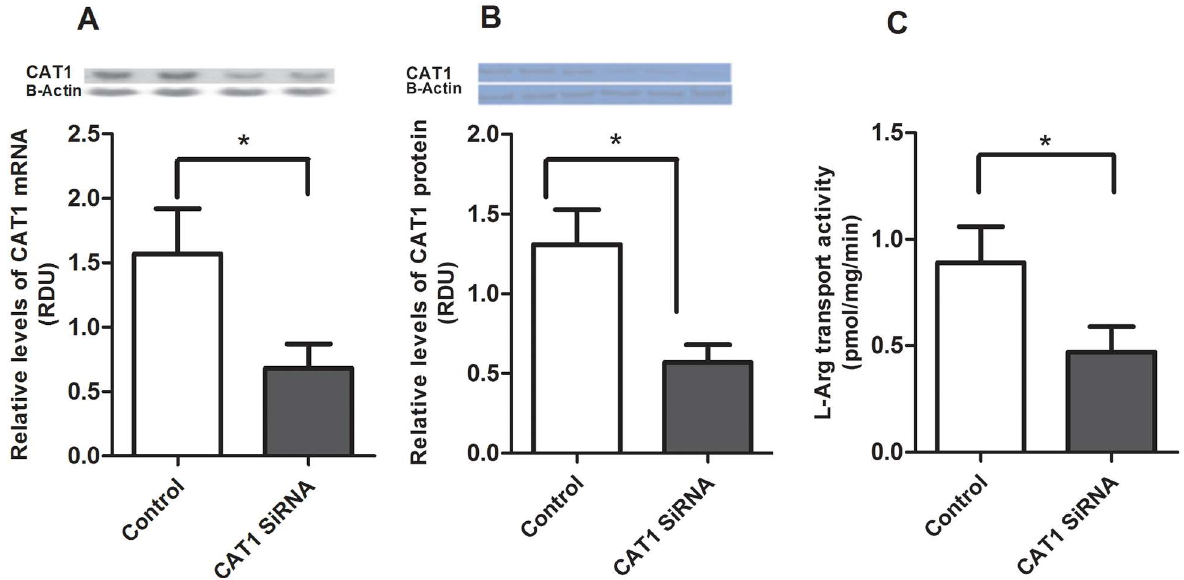
Fig 3. System y + CAT1 siRNA knocked down L-Arg transport activity, CAT1 mRNA and System y + protein. Caco-2 cells were transfectedsystem y + CAT1 siRNA for 24 hour as accordingto manufacturer’s instruction. L-Arg transport activity was measured as describedin Methods . Cell lysates were assayed for CAT1 mRNA and protein. A: CAT1 mRNA. The levels of CAT1 mRNA were determined by NorthernBlot analysis, then normalized to β -actin. System y + CAT1 siRNA knocked down CAT mRNA by 60%. B: System y + protein. Western blot analysiswas used to detect System y + protein and normalized to β -actin. C: L-Arg transport activity. Transport activity was expressedas picomolesL-Arg per milligramprotein per 1 min of uptake. Data are means ± SE, * P < 0.05.(n = 6 /group).